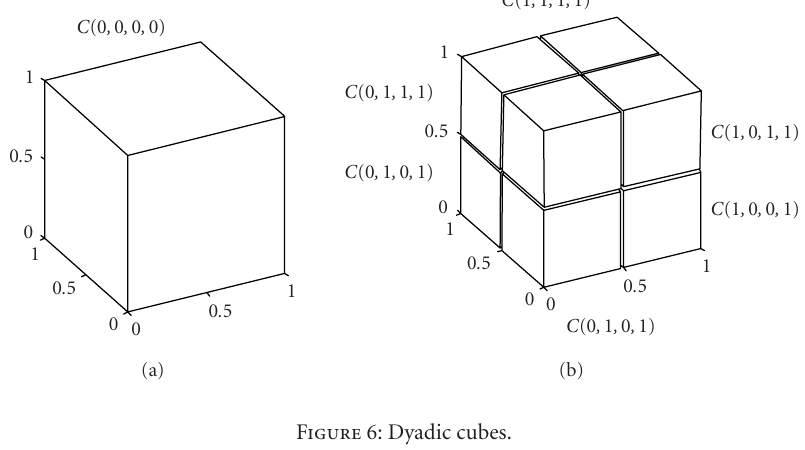
Figure 6: Dyadic cubes.